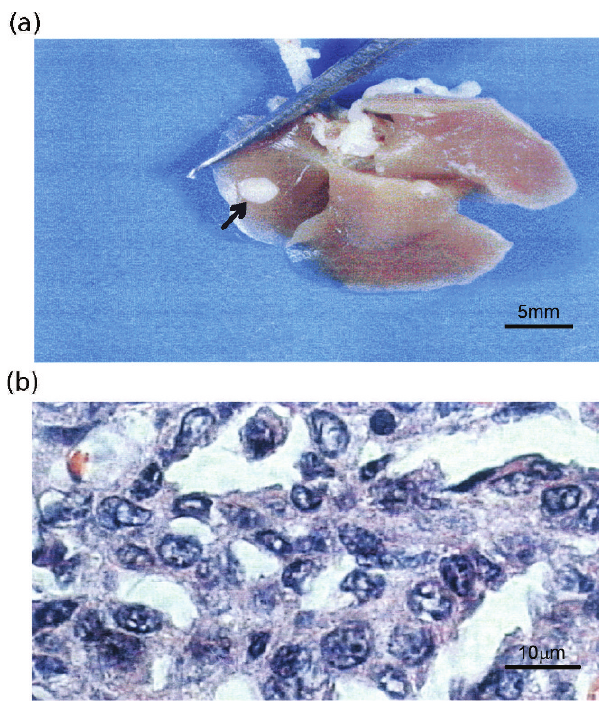
Figure 1 - (a) Photograph of lung obtained from urethane- treated animals showing nodule formation; (b) Photo- micrograph of tissue section obtained from fixed lungs of urethane-treated animals and stained with Hematoxilin and Eosin showing atypical adenoma. x 1000.